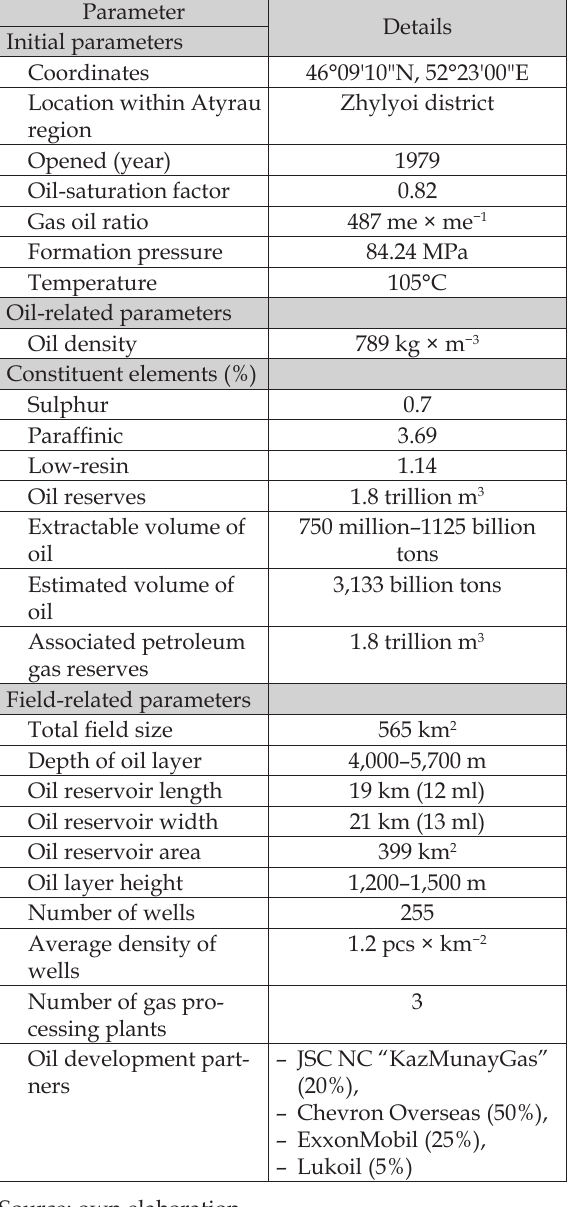
Table 2. Characteristics of the Tengiz oil field.